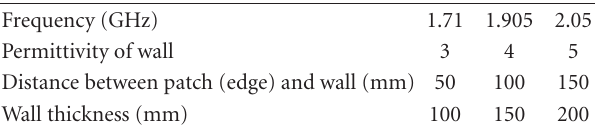
Table 1: Parameters of patch-wall